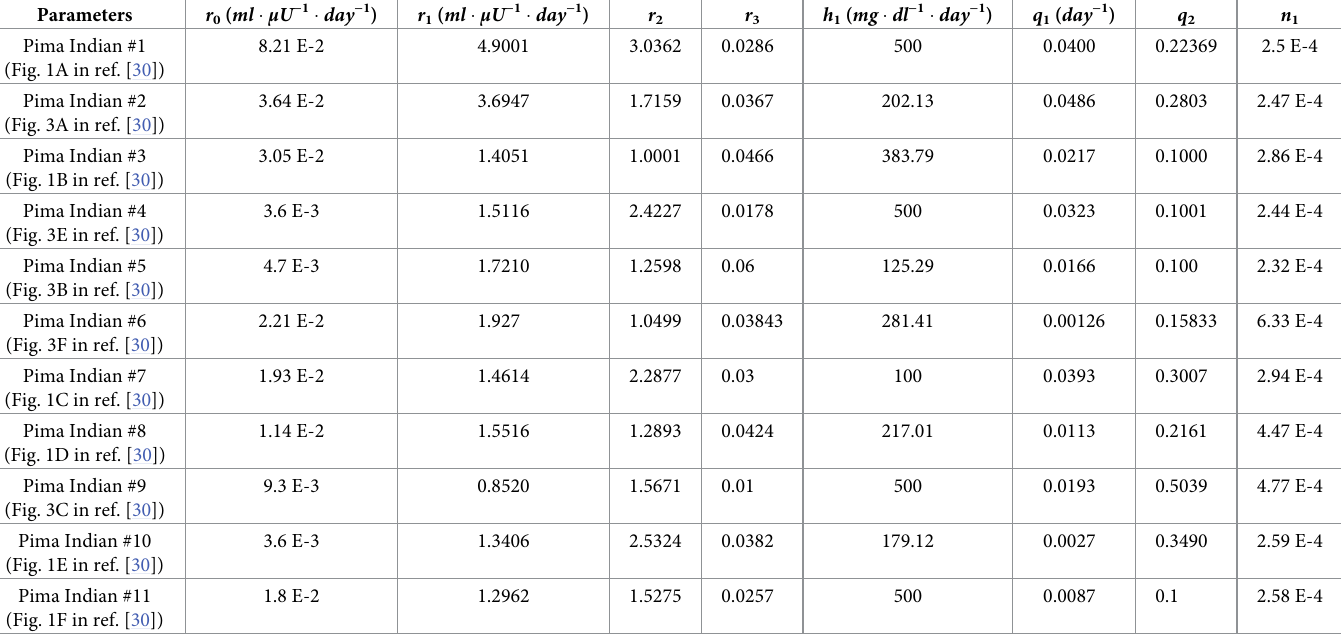
Table 2. Parameter values of the best fits of the obesity-related diabetes model to the glucose data of Pima Indian #1-#11.